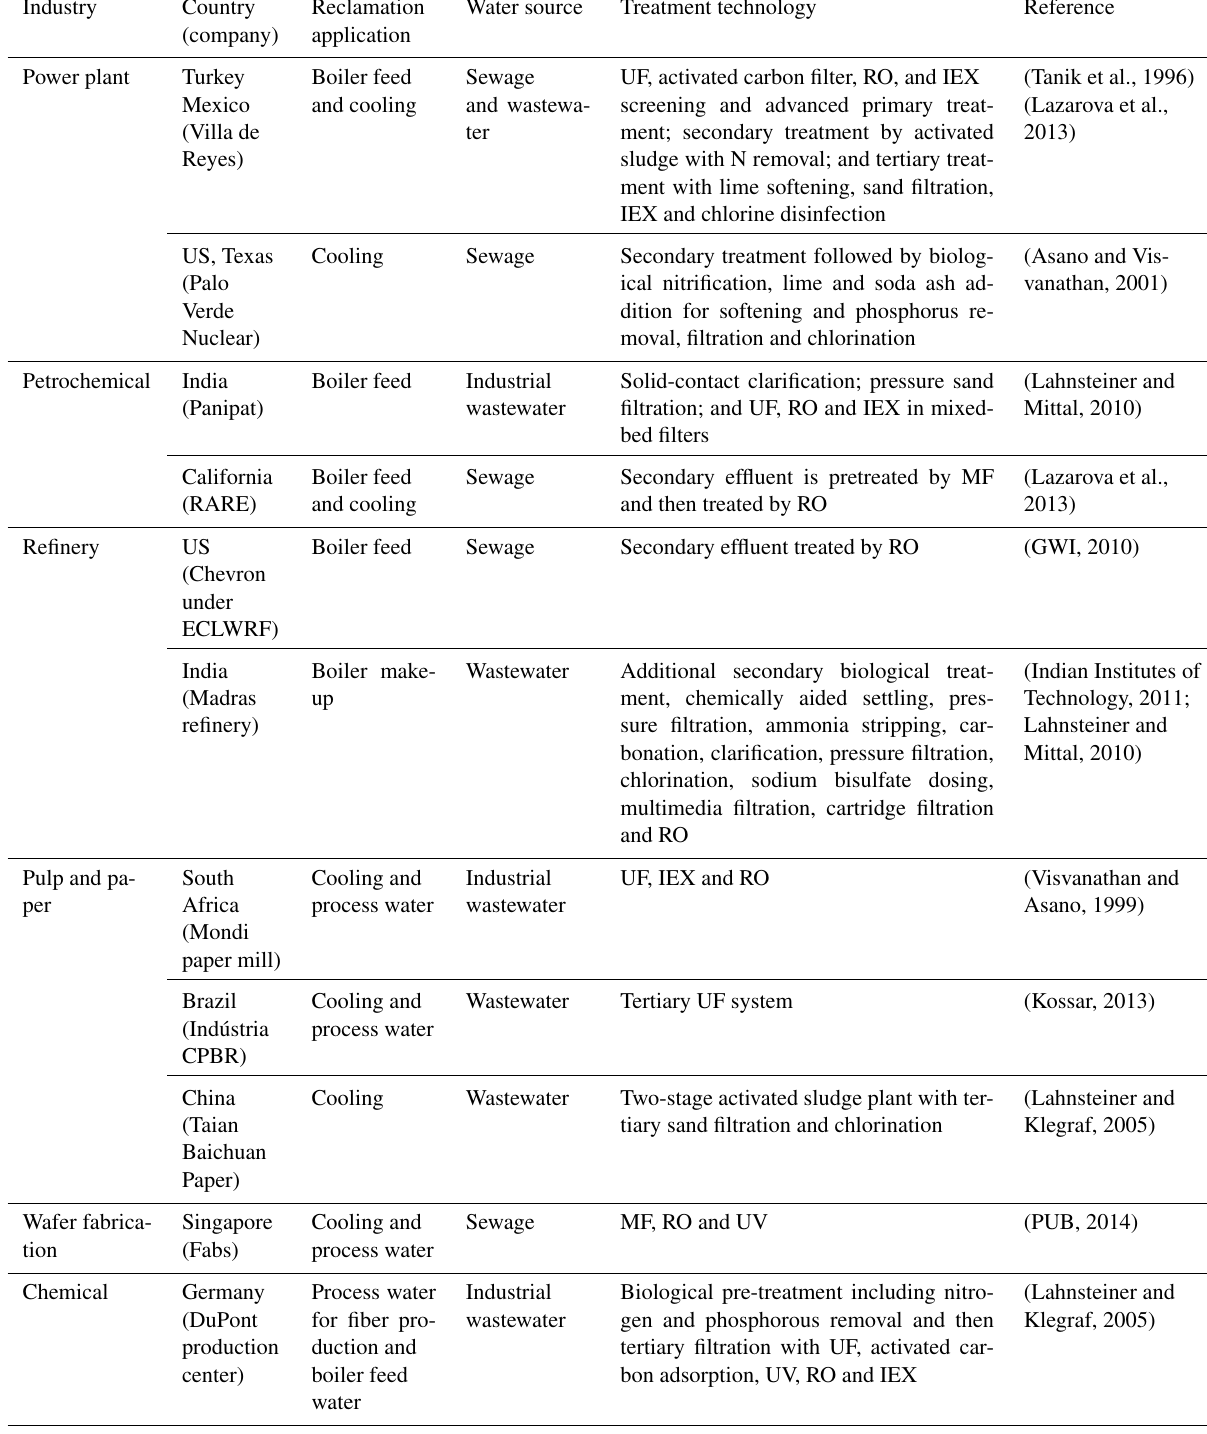
Table 4. Examples of industries that use reclaimed water. RO is reverse osmosis, UF is ultrafiltration and IEX is ion exchange.